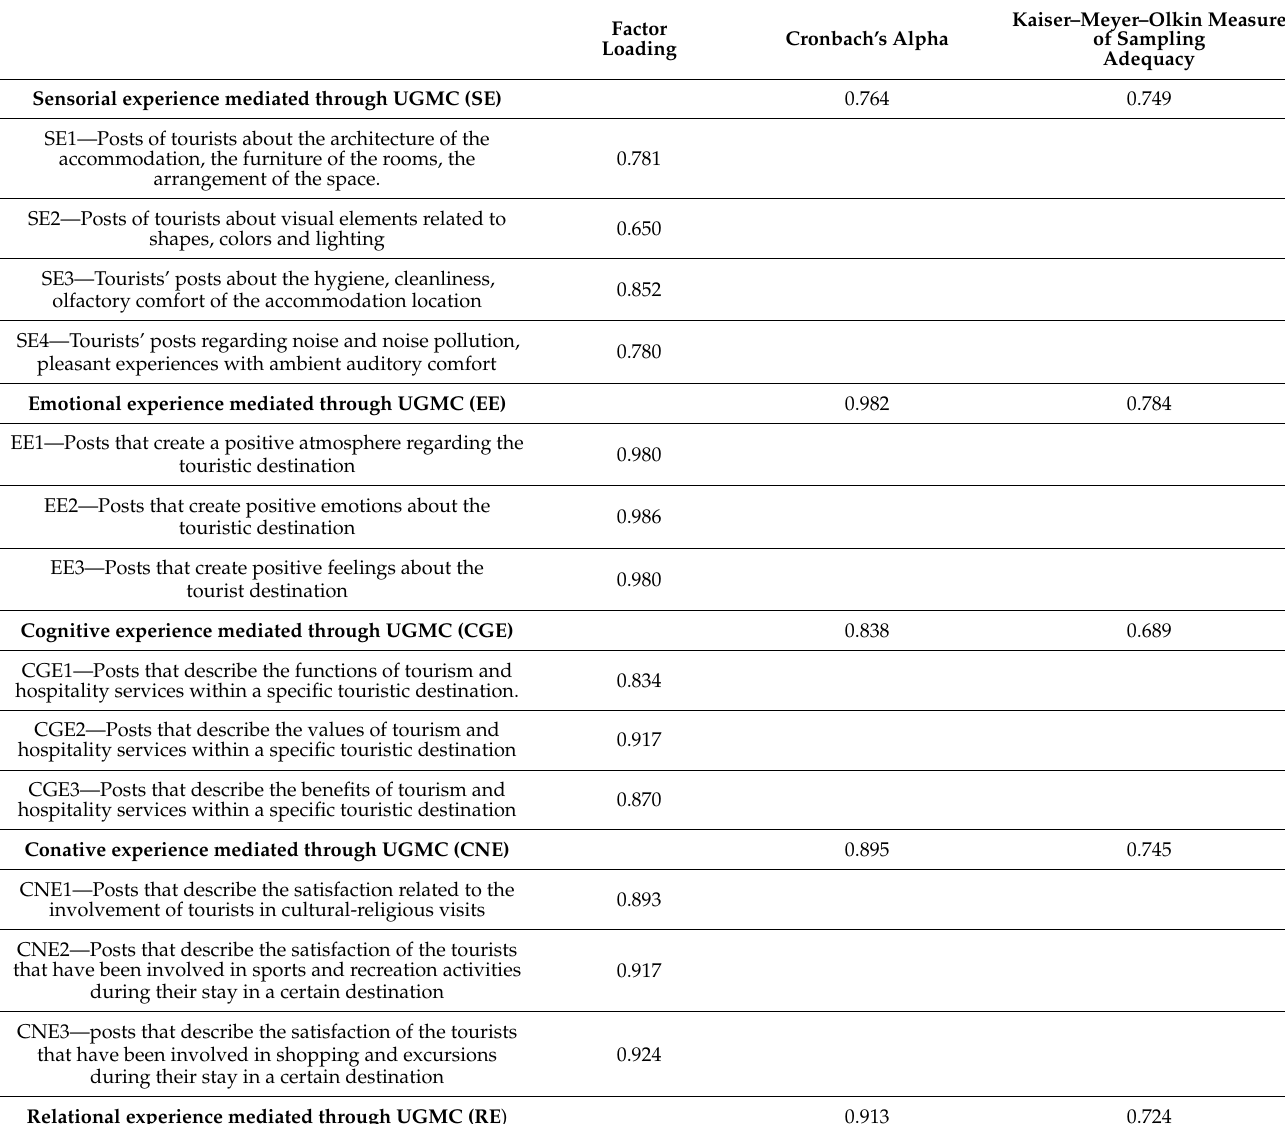
Table 2. The measurement model results at the level of each